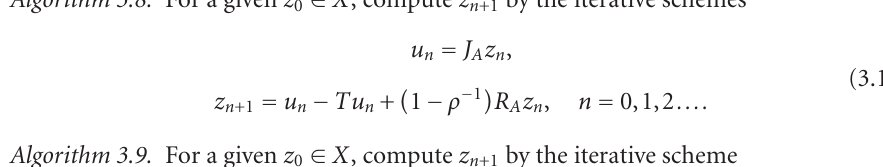
Algorithm 3.9. For a given z 0 ∈ X , compute z n +1 by the iterative